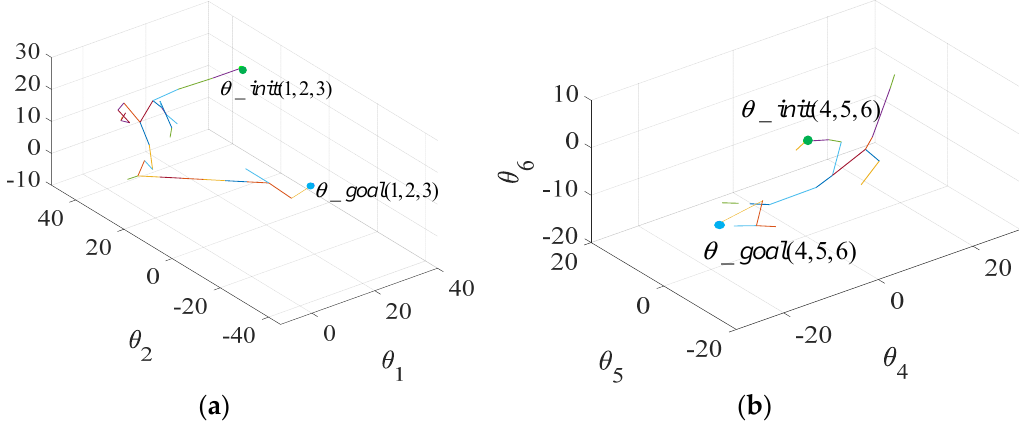
Figure 11. Exploration process of the salve arm: ( a ) the first three joint angles of the slave arm; ( b ) the posterior three joint angles of the slave arm.